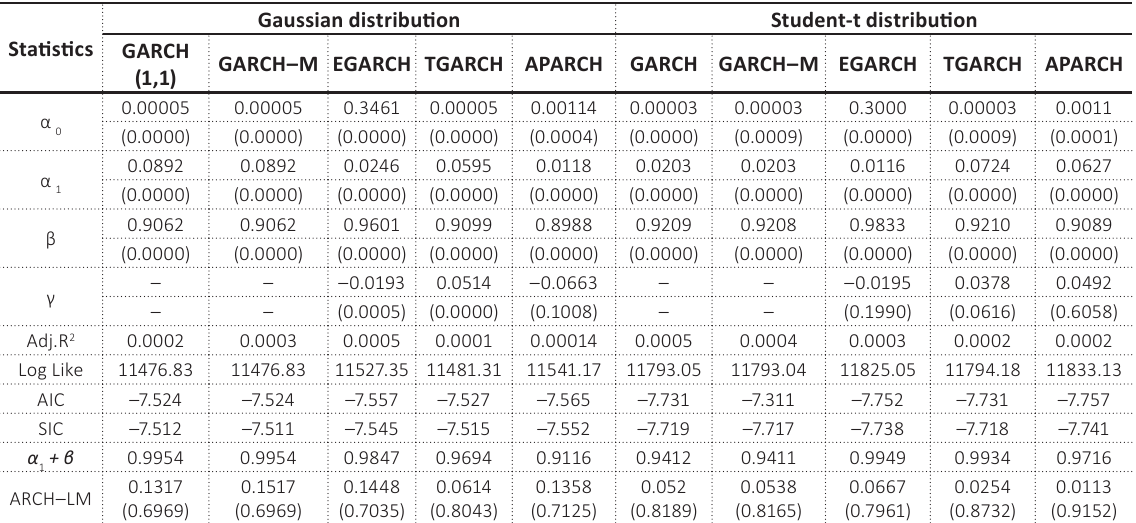
Table 5. Estimation result of GARCH models: Bond